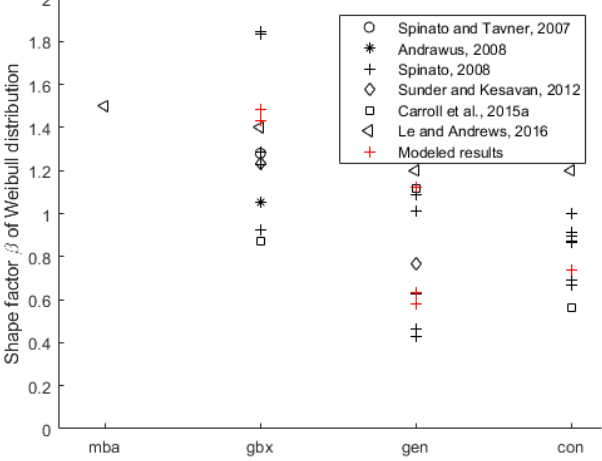
Figure 3. Components’ failure behavior from the literature and model results described by the Weibull shape factor (Spinato and Tavner, 2007; Andrawus, 2008; Spinato, 2008; Sunder and Kesa- van, 2012; Carroll et al., 2015b; Le and Andrews, 2016).